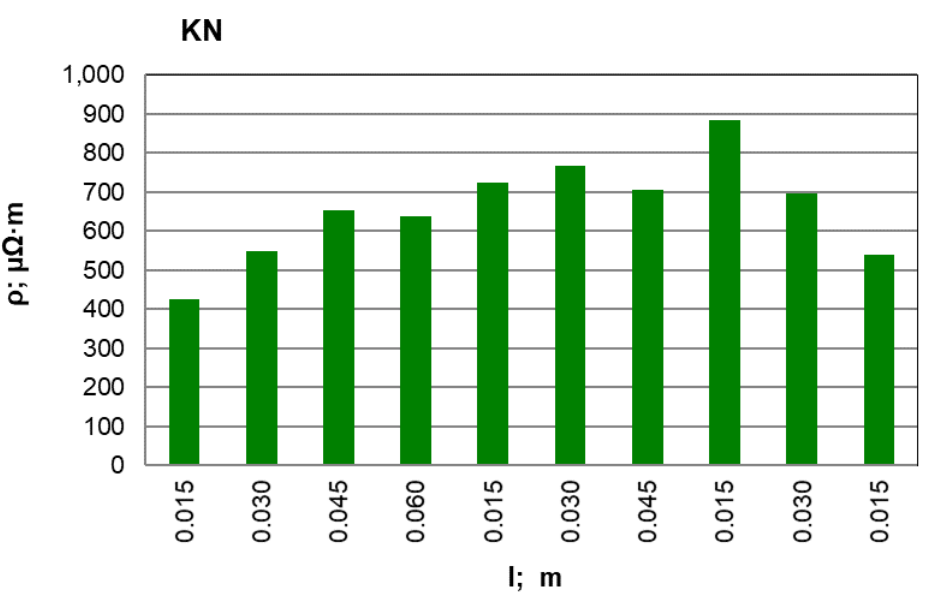
Figure 6. ANT material resistivity for various measuring electrode distances l; m